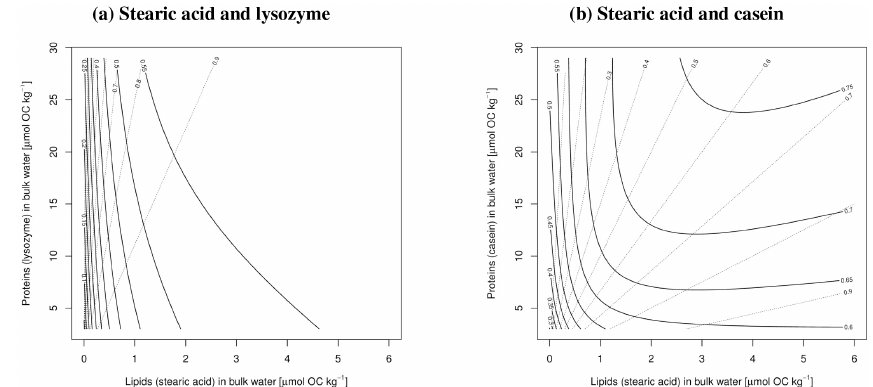
Figure 5. Organic mass fractionation in a two-component model including stearic acid and either lysozyme or casein (with properties as specified in Tables 1 and 2) and over a range of OC concentrations estimated from the ocean biogeochemical model as described in Sect. 5. Dark solid lines show total organic mass fraction of film aerosol. Thin dashed lines show the fraction of organic mass that is contributed by stearic